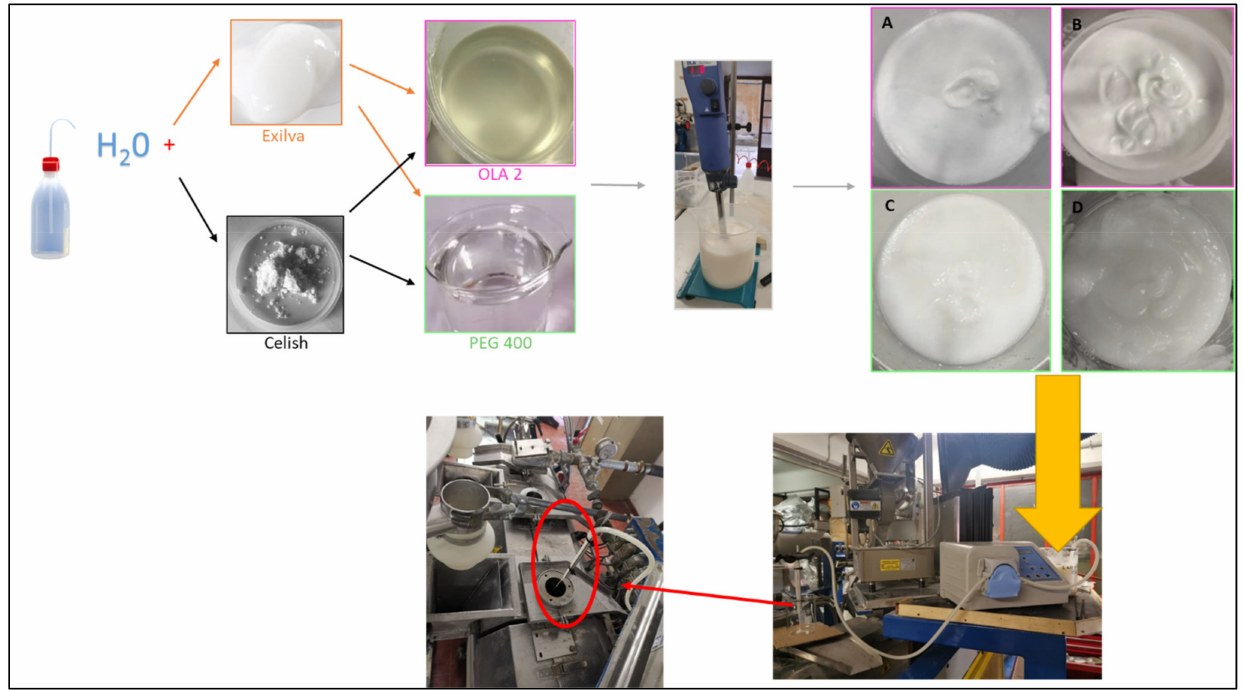
Figure 11. Scheme of the emulsion preparation with MFCs, OLA, and PEG to achieve OLA_15_EX ( A ), OLA_15_CE ( B ), PEG_15_EX ( C ), and PEG_15_CE ( D ). The emulsion emission in the semi-industrial extruder through a peristaltic pump is also shown.